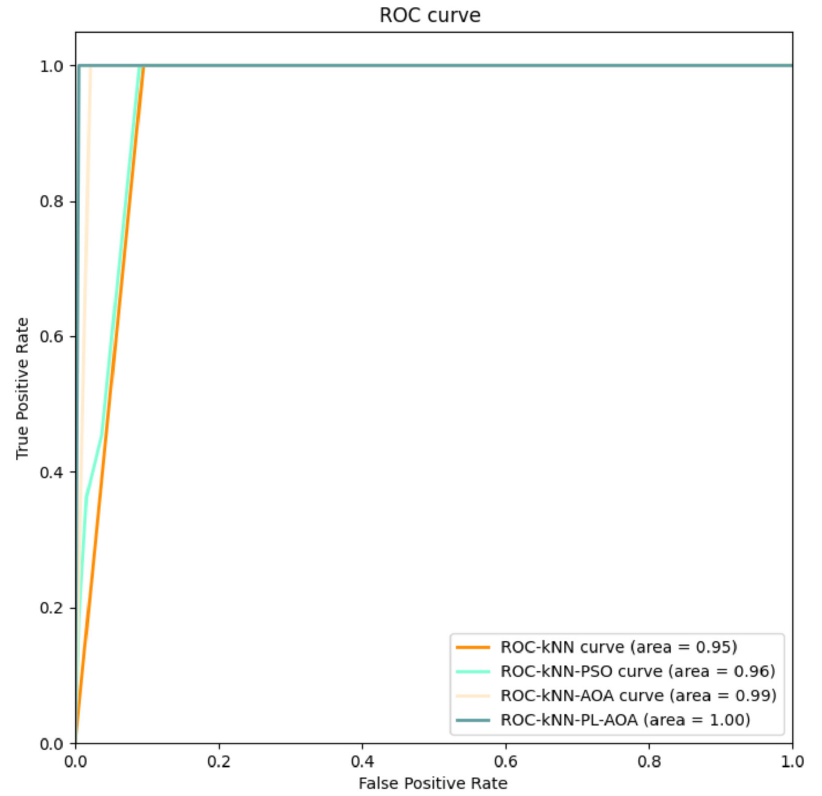
Figure 7. The AOC curves for kNN, kNN PSO , kNN AOA , and kNN PL − AOA